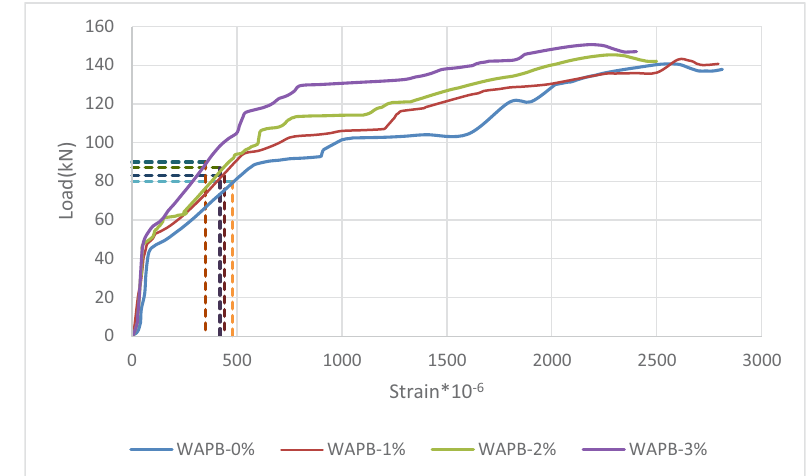
Figure 6: Load – strain curves for concrete tension zone at midspan ( Sg. 6 ) .